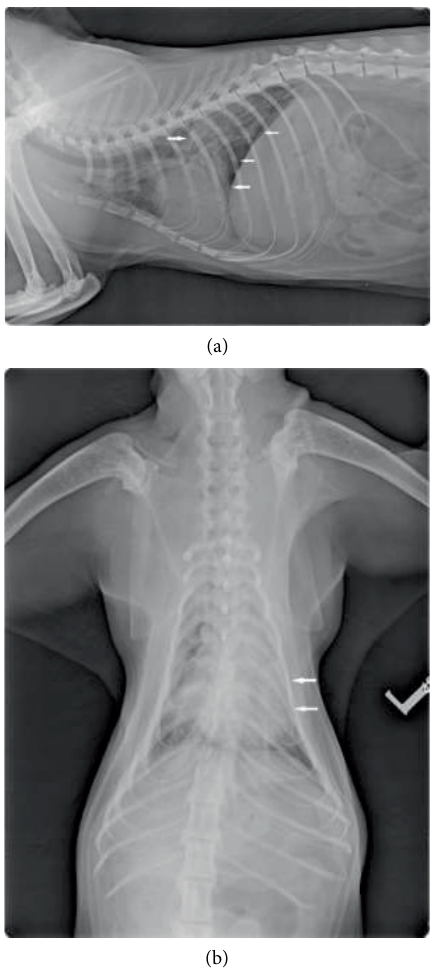
Figure 1: (a) Laterolateral right radiographic view: there is a mild right ventricular enlargement. Caudal lung field show/exhibit interstitial-to-alveolar patterns with air bronchograms (arrows). (b) Dorsoventral view. An alveolar lung pattern is apparent/obvious especially in the left cranial and caudal lung lobes (arrows).